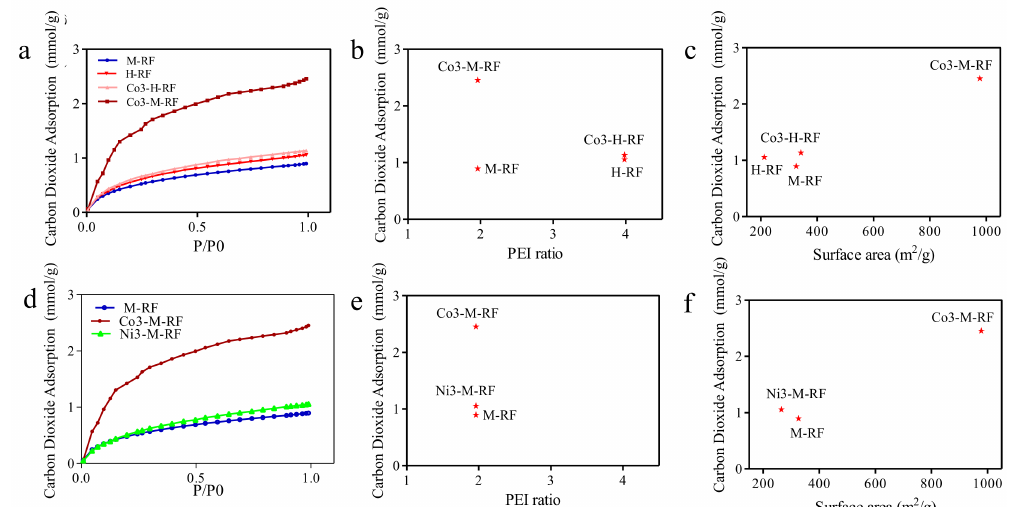
Figure 4. Carbon dioxide adsorption of various composition ( a ) at 0 ◦ C, vs. P/P 0 ( b ). CO 2 adsorption at 0 ◦ C vs. PEI % weight in MRF ( c ) CO 2 adsorption at 0 ◦ C vs. Surface area ( d ) Carbon absorption at 25 ◦ C vs. P/P 0 ( e ) CO 2 adsorption at 25 ◦ C vs. PEI % weight in MRF ( f ) CO 2 adsorption at 25 ◦ C vs. Surface